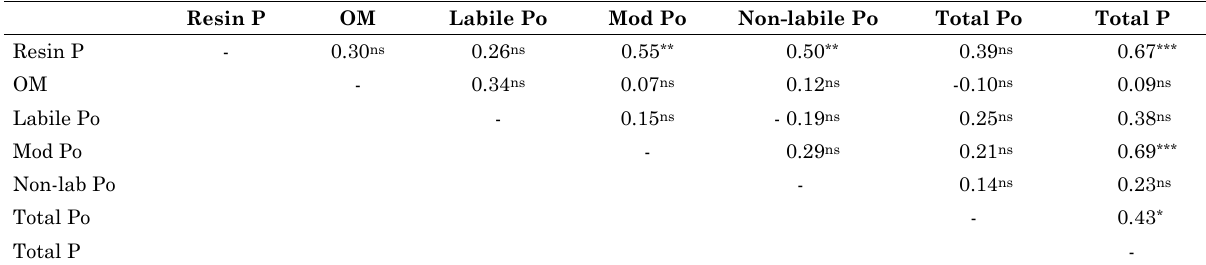
Total P ns , *, **, and ***: non-significant, significant at p<0.05, p<0.01 and p<0.001,